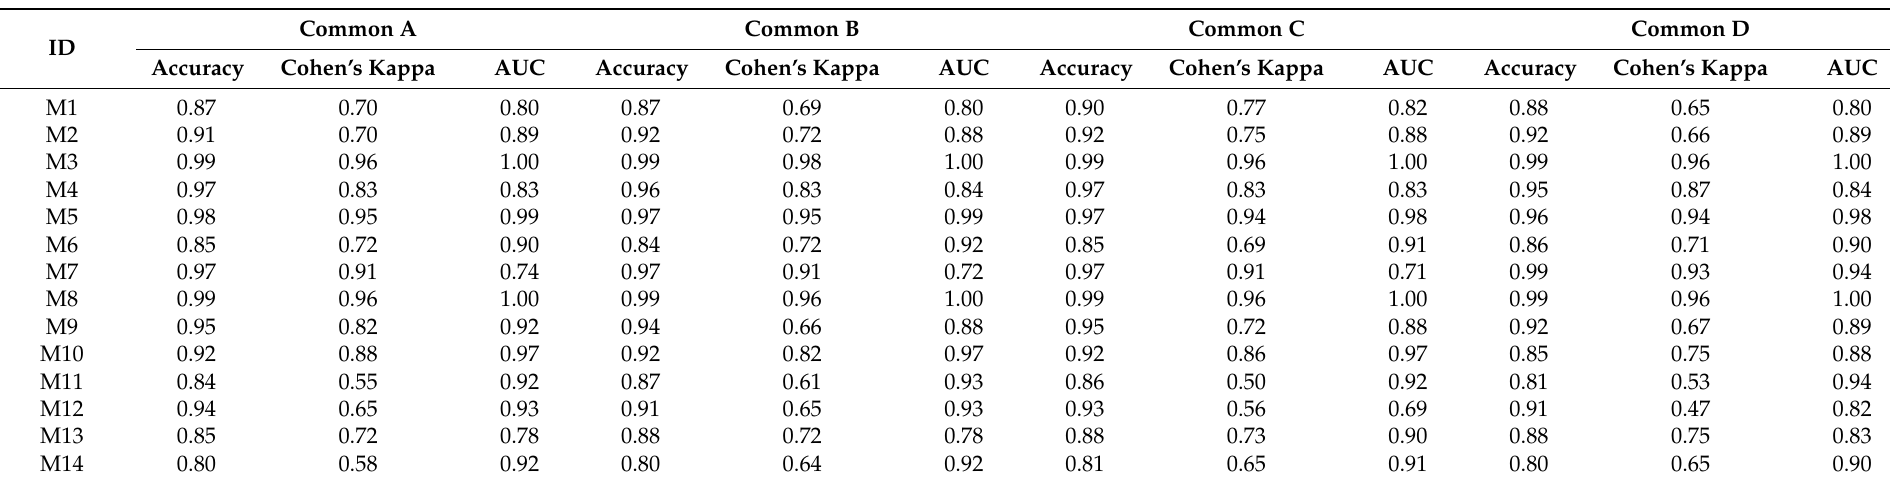
Table 5. The accuracy, Cohen’s kappa, and AUC of the four selected common combinations in the